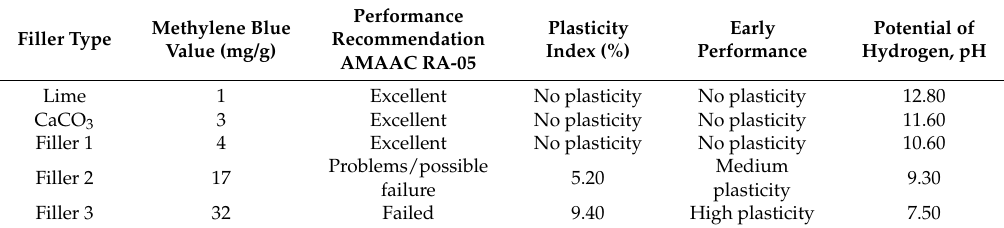
Table 5. Methylene blue absorption, plasticity index, and pH values of analyzed fillers.